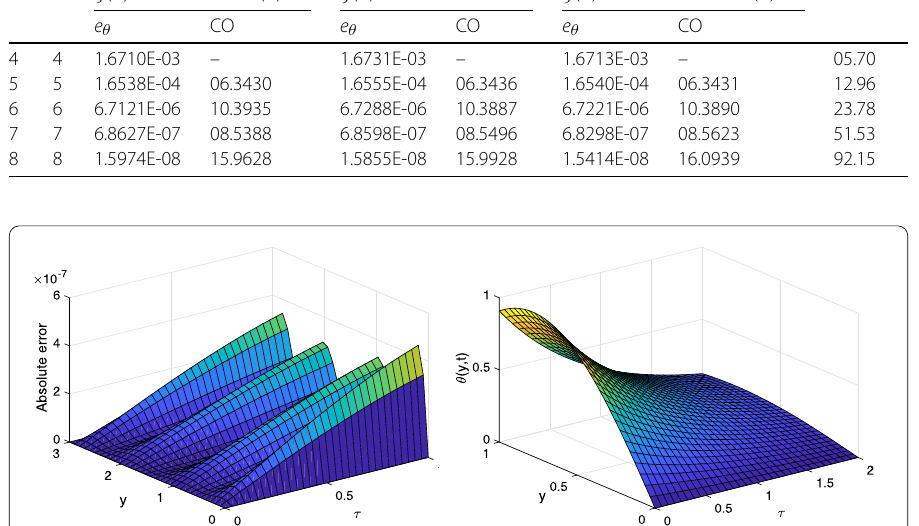
Table 2 Results extracted via the presented approach for Example 2 with three choices of ζ ( τ ) M